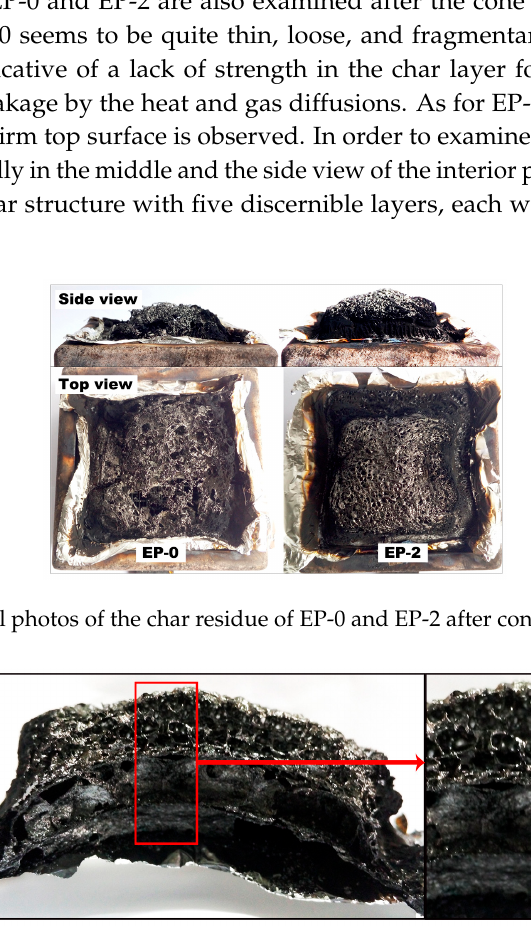
Figure 8. Scanning electron microscopy (SEM) images of the char residue of EP-2 after vertical burning test.